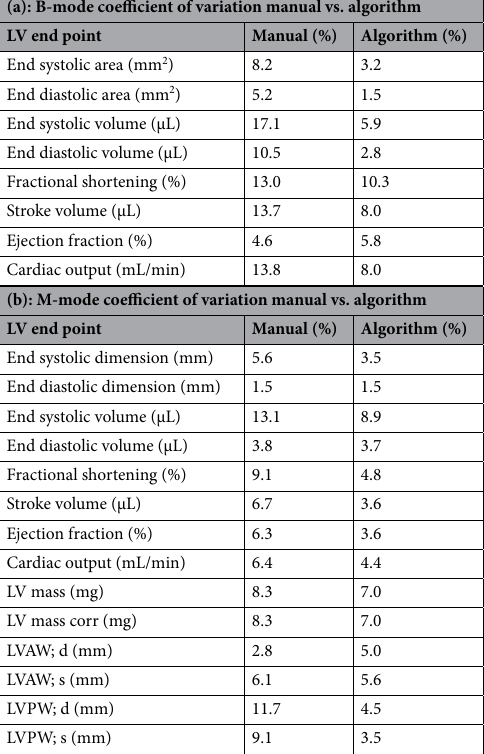
Table 3. Data tables displaying coefficient of variation analysis percentages between manual segmentation and semi-automated algorithm segmentation. (a) details long axis B-mode COV averages and (b) details short axis M-mode COV averages from analyzing the same data set of echocardiograms in triplicate using the manual analysis method compared to using the semi-automated segmentation